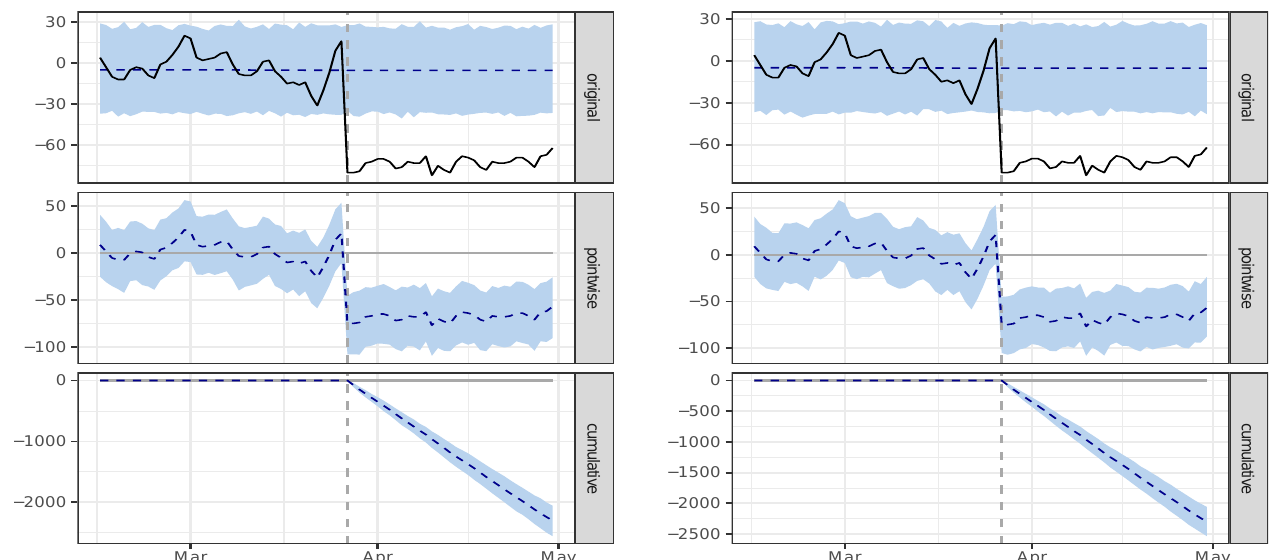
Figure 9. Left : Effect of the national full lockdown Level 5 on grocery and pharmacy Right : Effect of the national full lockdown Level 5 on retail and